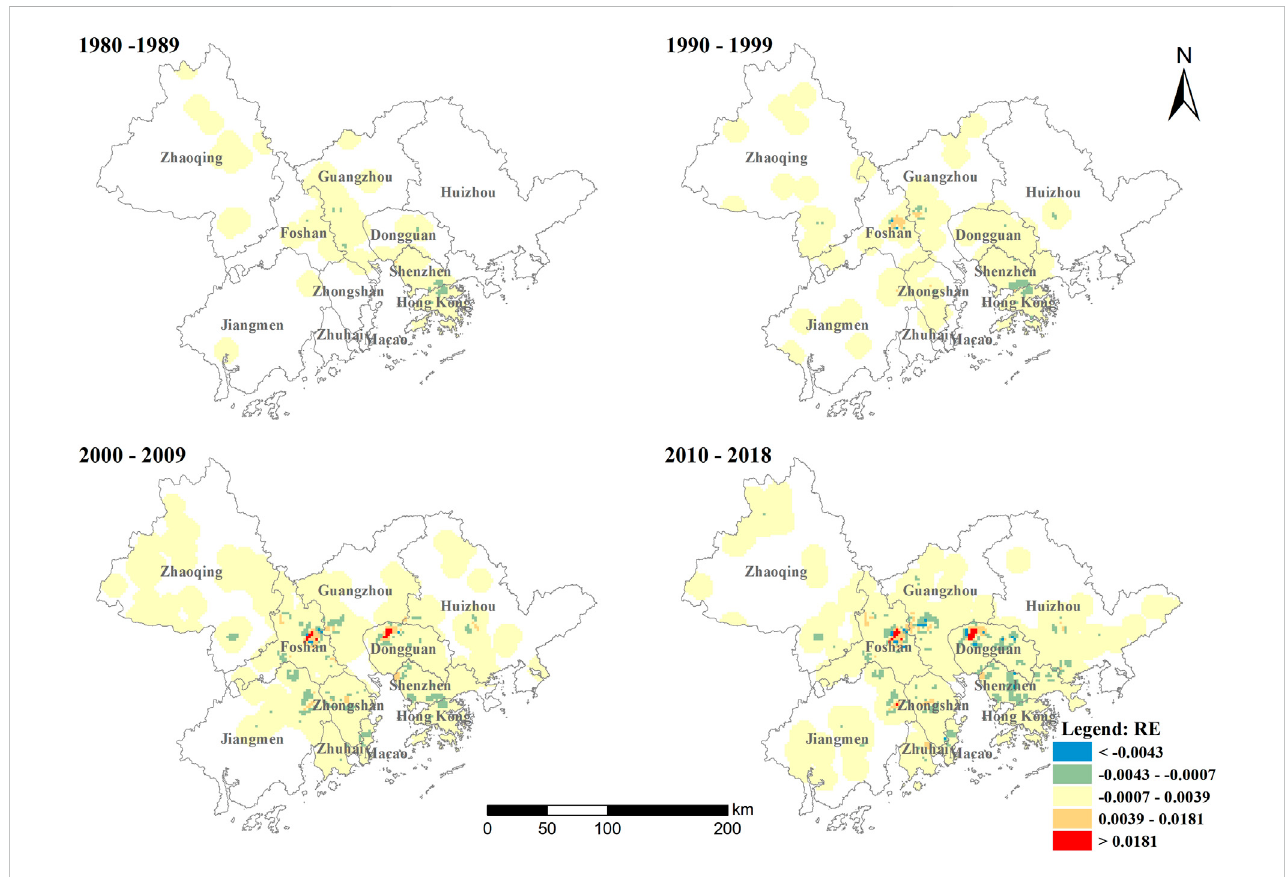
FIGURE 9 Spatial distribution of regression coef fi cients for RE during 1980 –